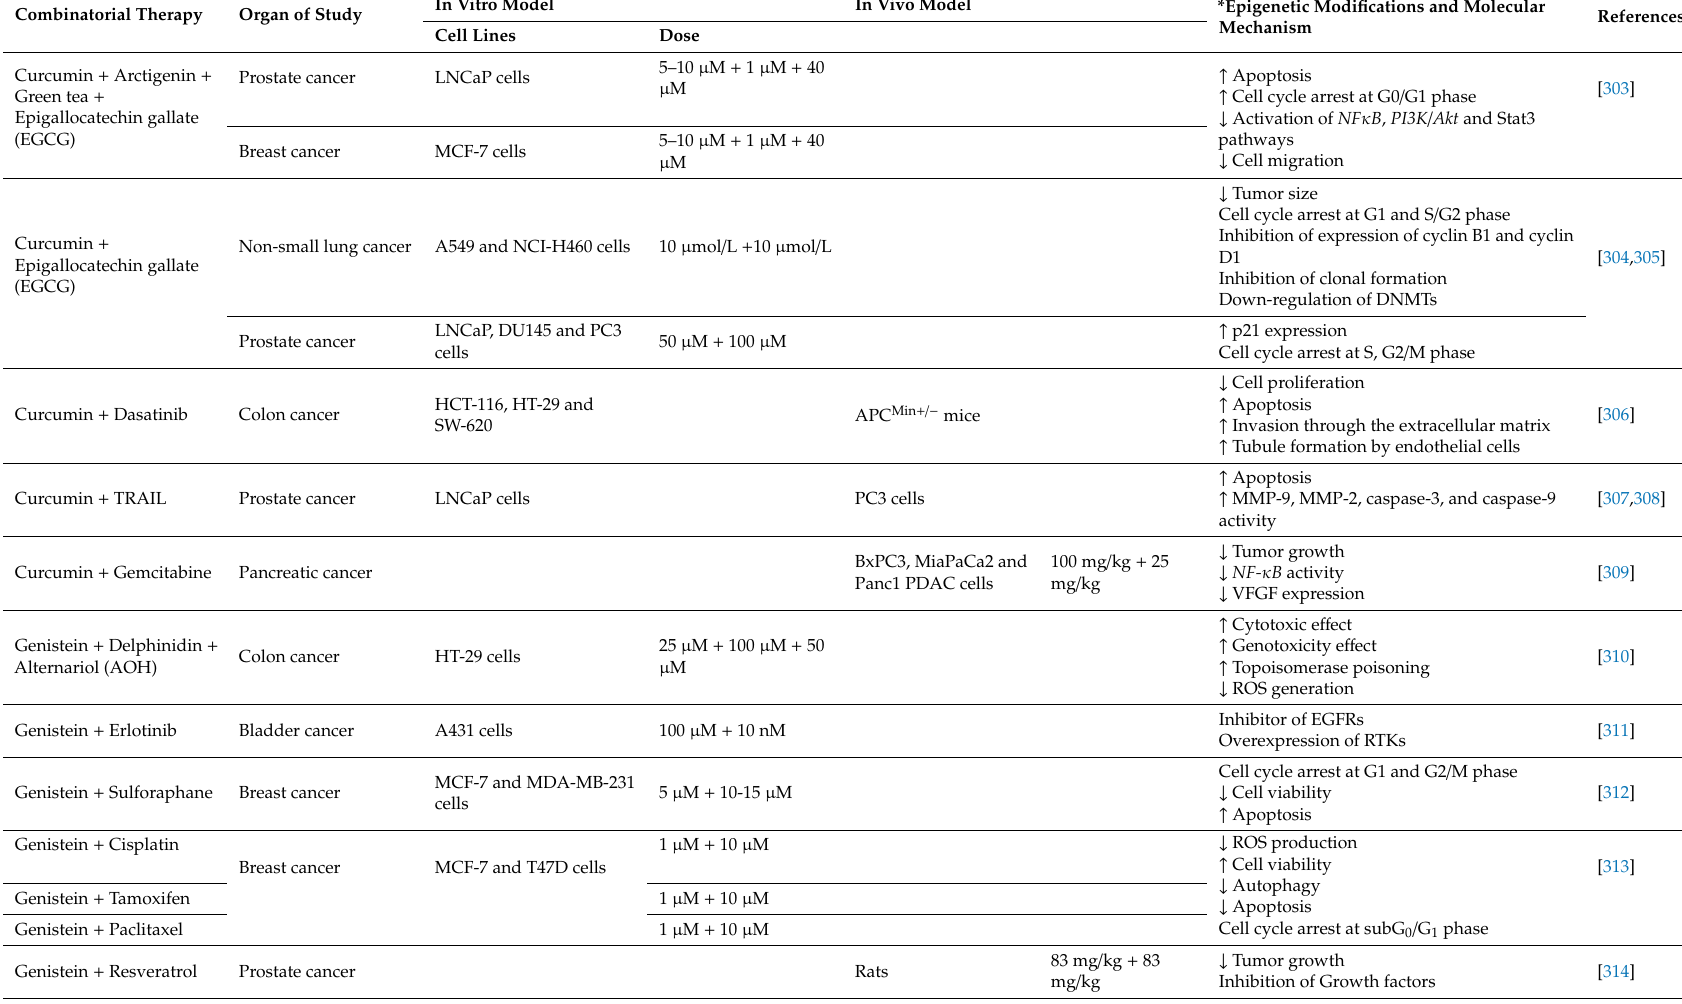
Combinatorial Therapy References Cell